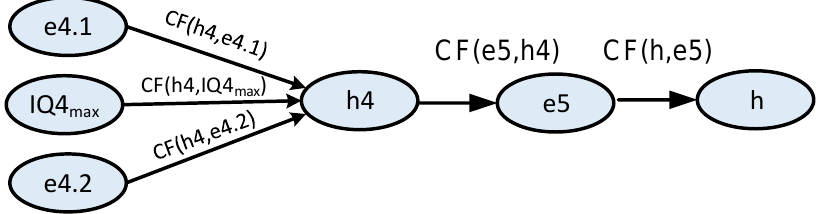
Figure 9. IQ model for the example with double traffic lights (the authors’ own study).